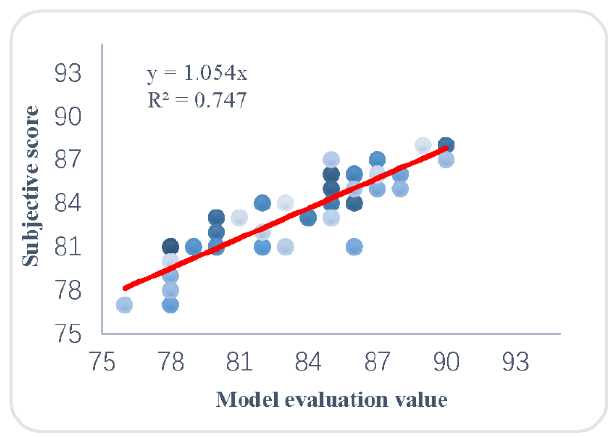
Fig. 8 Evaluation correlation analysis of management facilities.